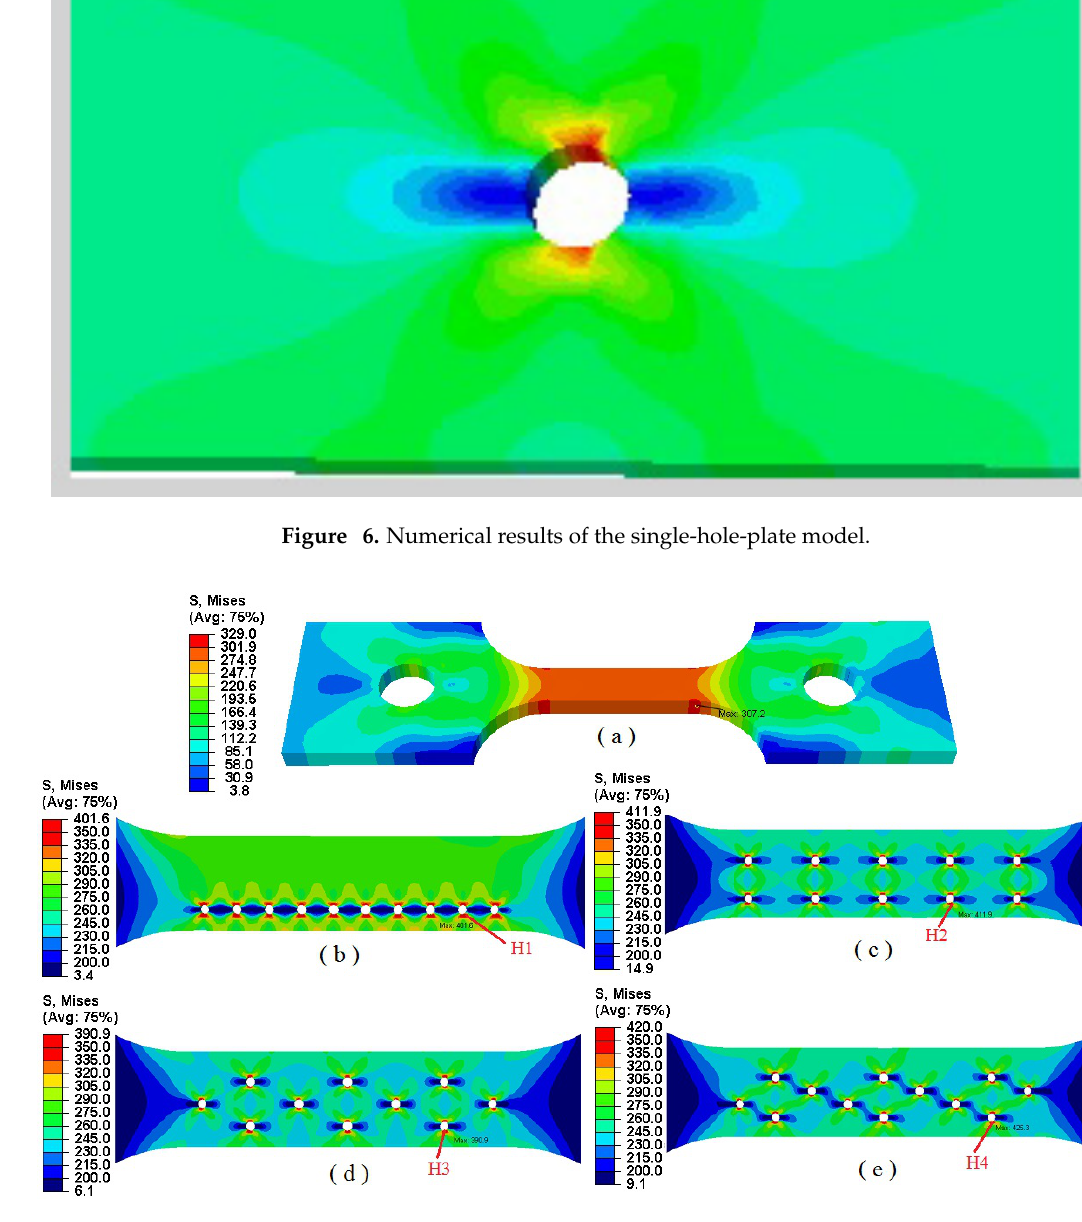
Figure 7. Stress distribution contours of specimens with different film-hole configurations: ( a ) zero-row, ( b ) one-row, ( c ) two-row, ( d ) three-row, ( e )